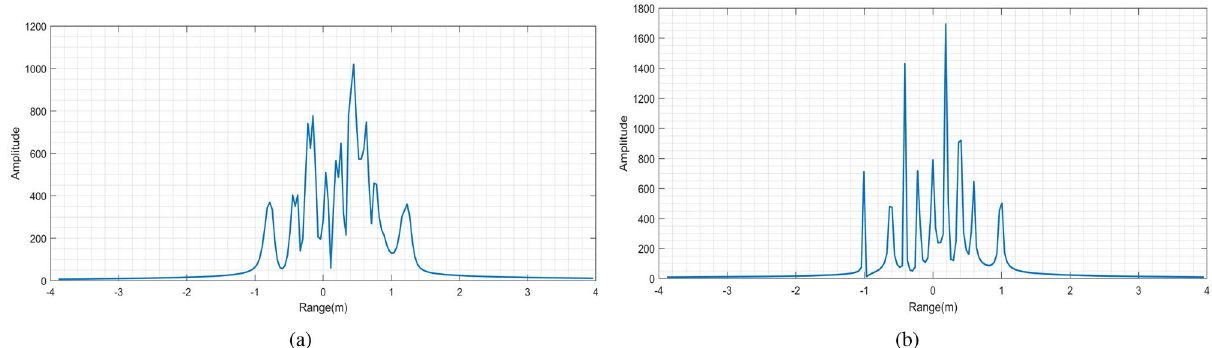
Figure 10. Range profile. ( a ) Range profile before compensation. ( b ) Compensated range profile.